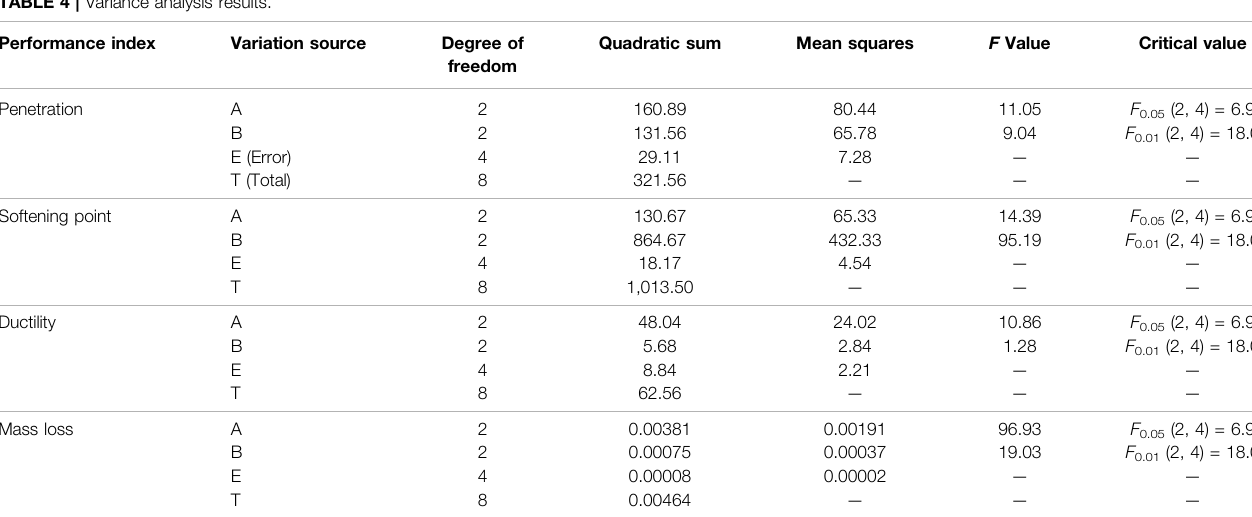
TABLE 4 | Variance analysis